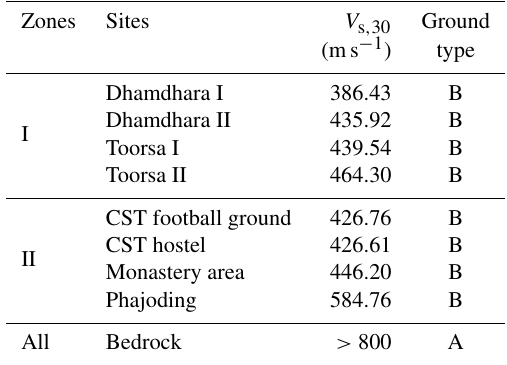
Table 2. Site classification as per Eurocode EC-08.